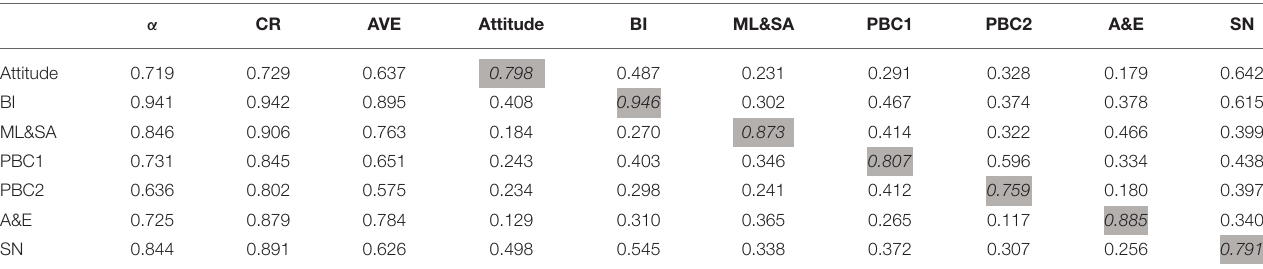
TABLE 4 | Correlations among variables ( n =